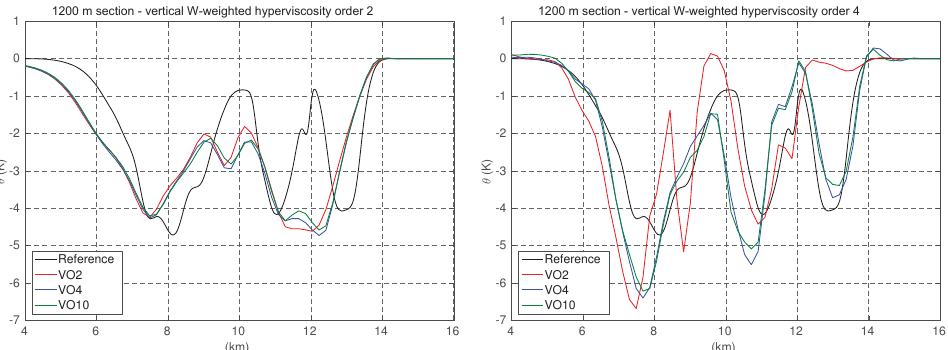
Figure 15. Straka density current test at vertical order 2, 4, and 10. Coarse, evaluation resolution of (cid:49)x = 190m and (cid:49)z = 160m shown. Vertical flow-dependent diffusion of derivative order 2 and 4 compared at 1200m with the reference solution ( (cid:49)x = 25m and (cid:49)z = 25m). Results for Lorenz (LOR) staggering shown.